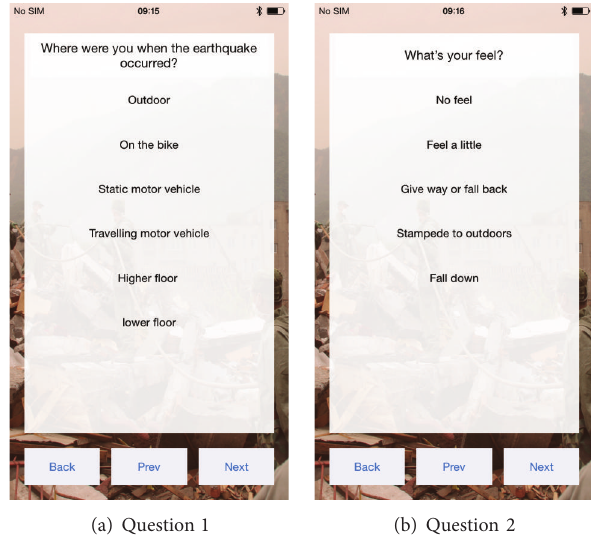
Figure 16: Screenshots of the